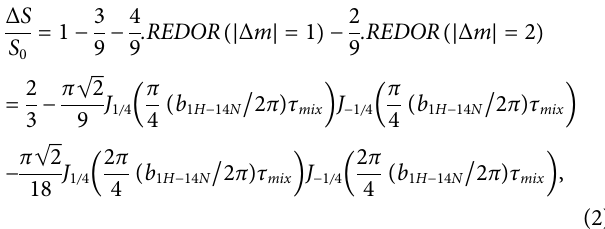
FIGURE3| Thepopulation transfers and theirprobabilities( W universal